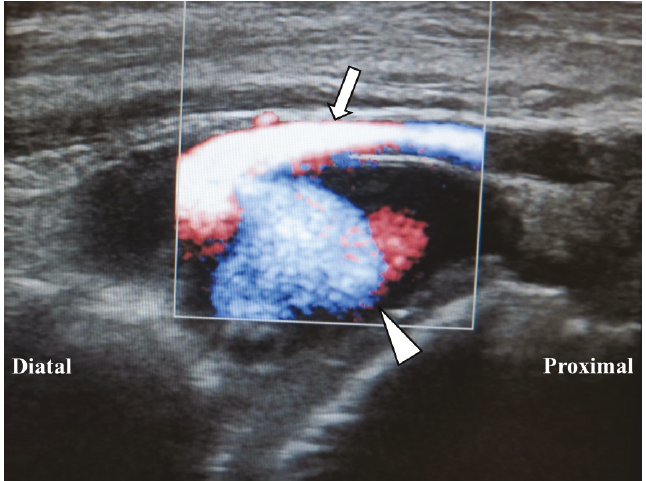
Figure 4: Color and duplex Doppler ultrasonography showing fl ow through the perforating peroneal artery (arrow) at the anterolateral ankle joint, suggesting a pseudoaneurysm (arrowhead) leaking into the ankle joint. Flow toward and away from the transducer is indicated by red and blue,